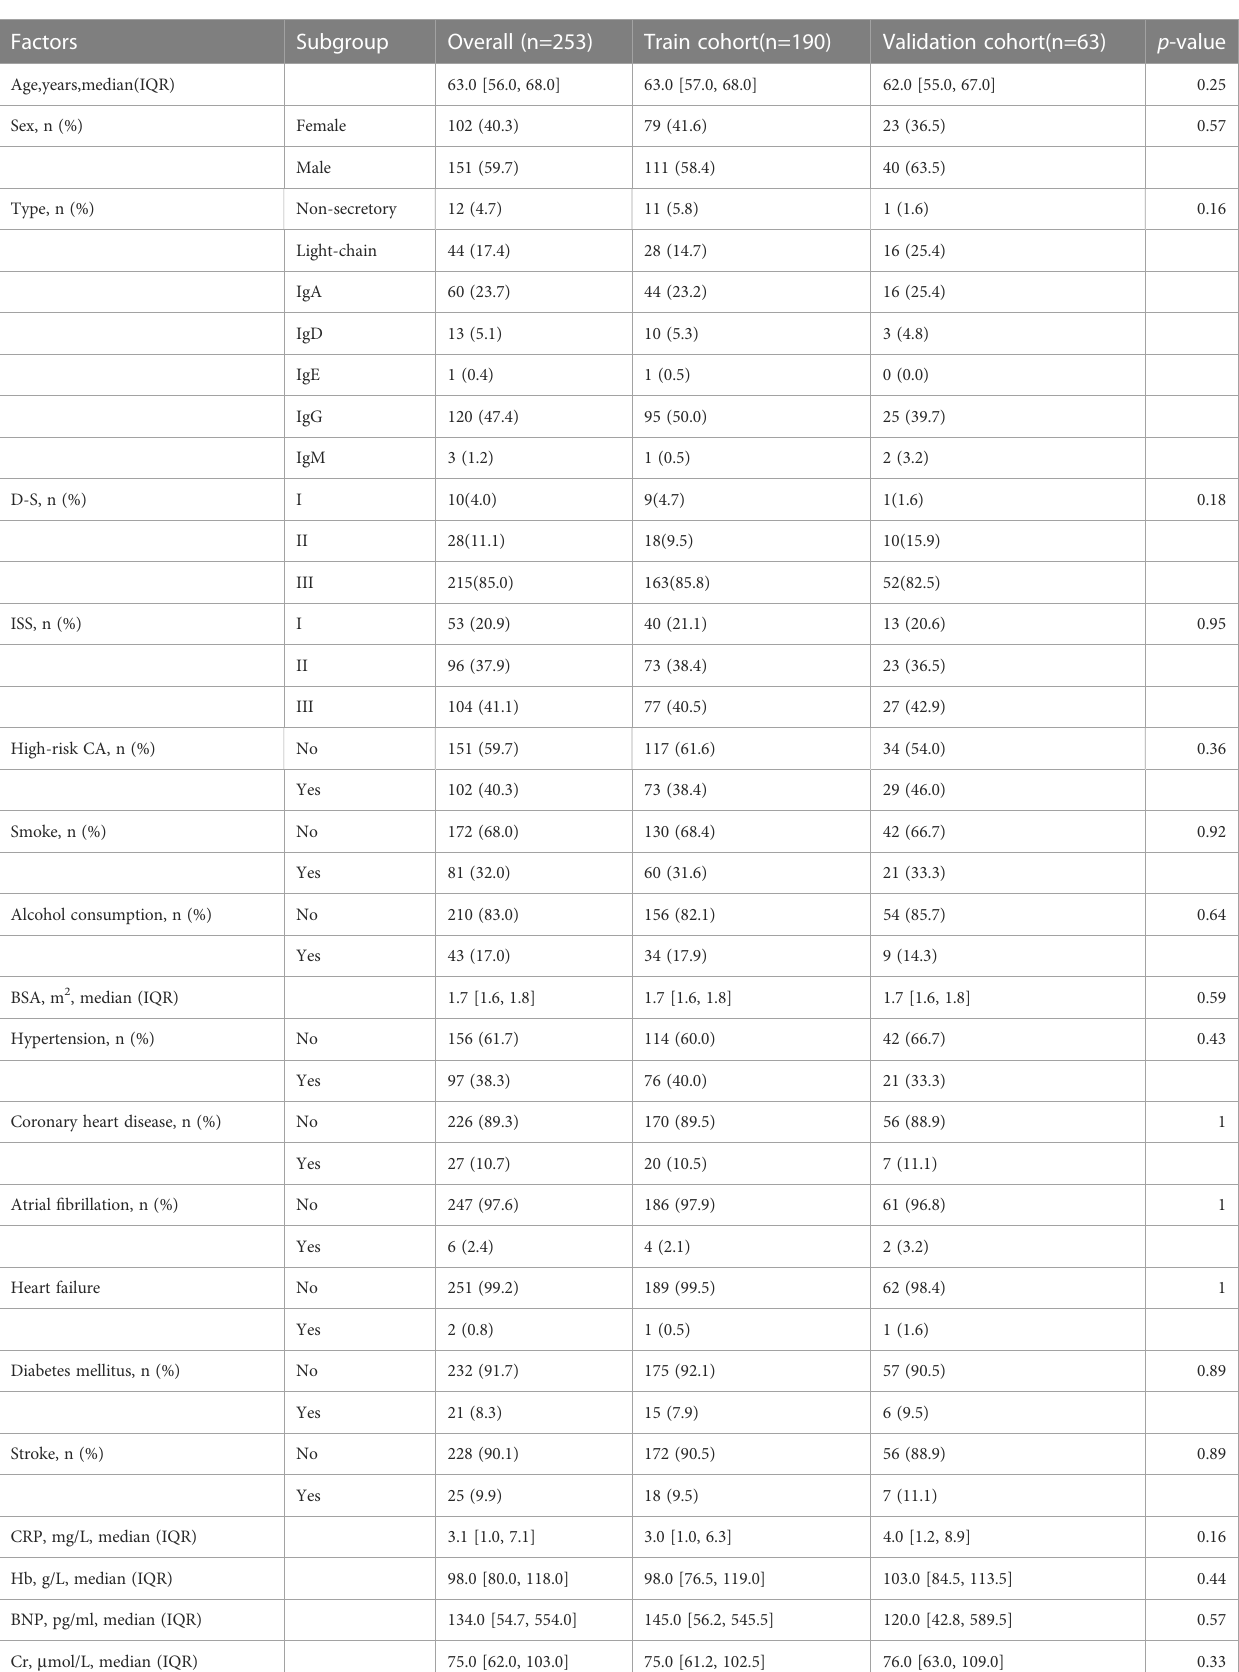
TABLE 2 The baseline characteristics of the train and validation